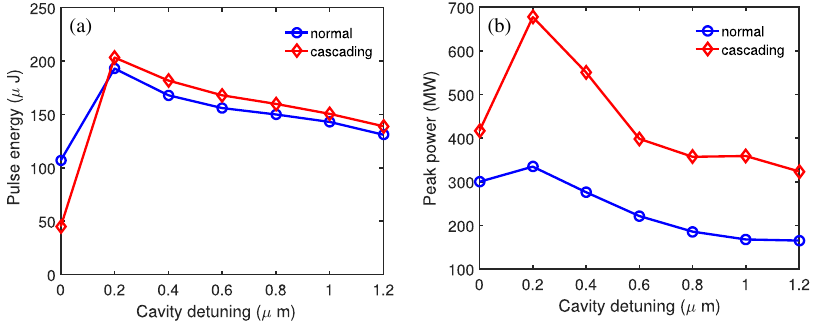
FIG. 4. The cavity detuning curve for (a) output energy and (b) peak power.